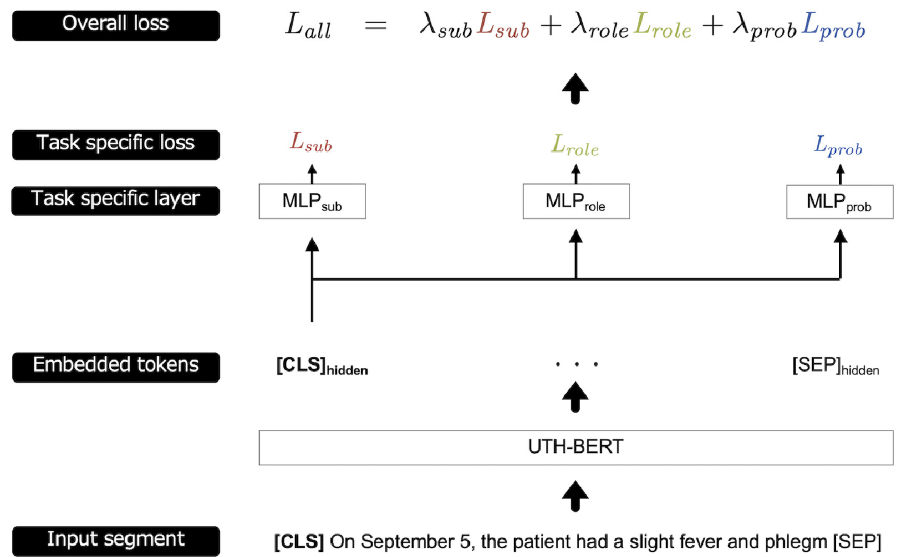
Fig 2. Overview of the classification model for subjectivity, clinical role, and probable label. Each of the three labels is defined as three tasks. Input segments are fed to UTH-BERT, and then the outputs to the specific layers. Finally, the loss scores of three tasks are calculated and combined to obtain the overall loss